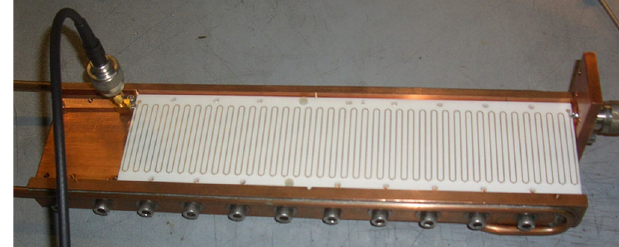
FIG. 3. Picture of the measurement setup for the meander line of the single bunch